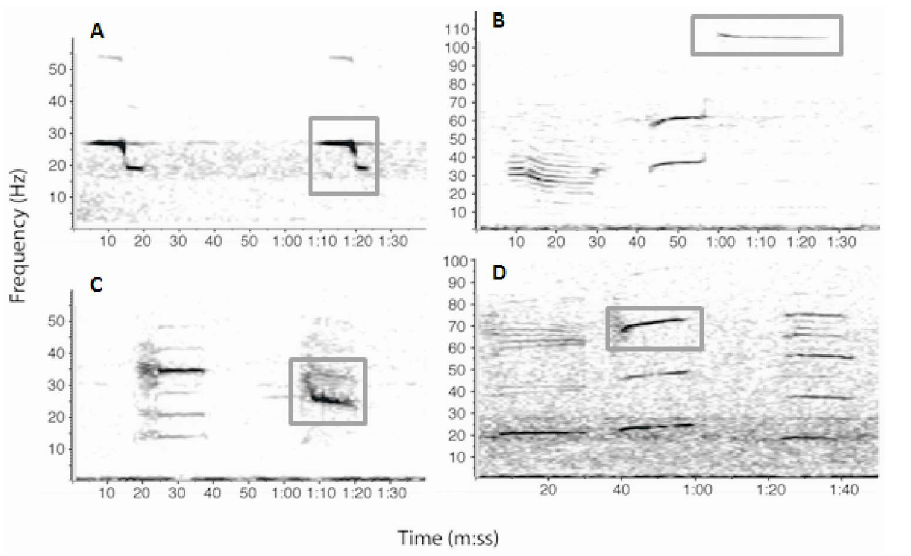
Figure 1. Example spectrograms from different acoustic populations of blue whale in the Indian Ocean. A: Antarctic; B: Sri Lanka; C: Madagascar; D: Australia (512 pt FFT, 87.5% overlap Hanning window). Boxes represent the part of the call used for the automated detection.